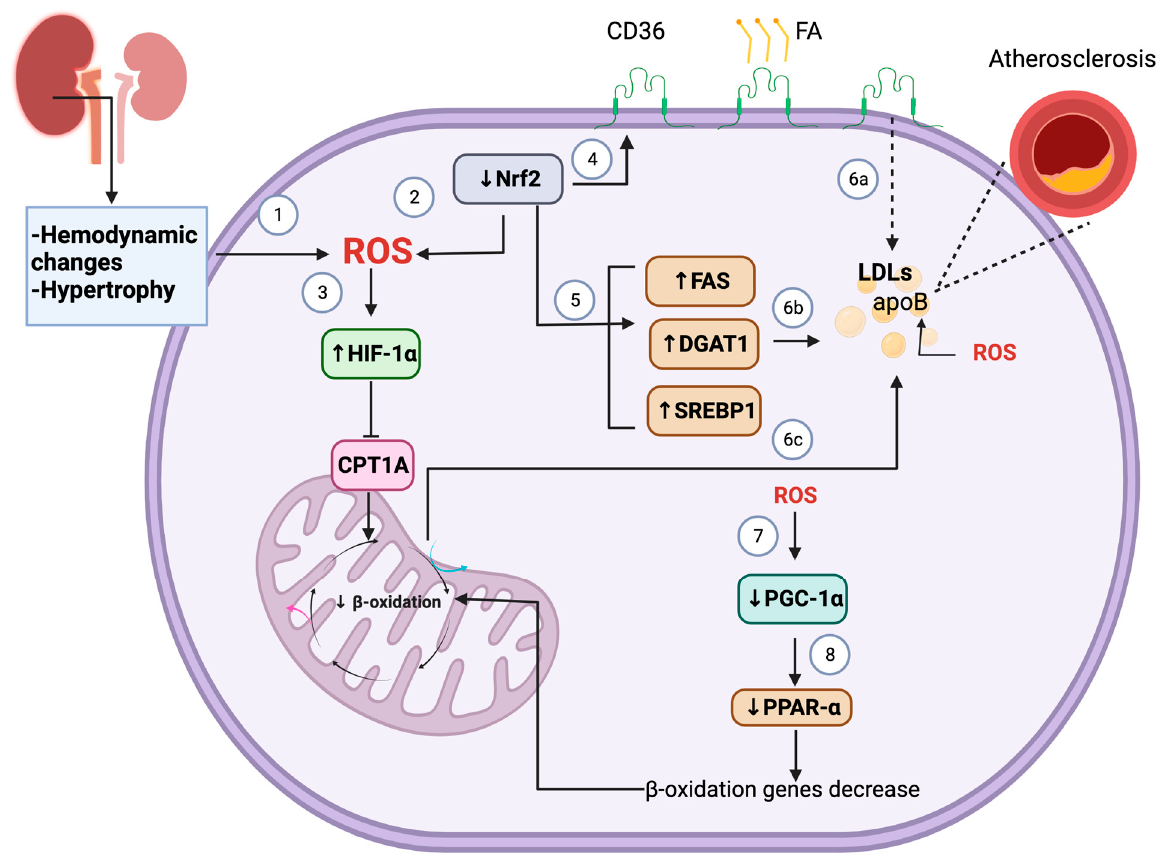
Figure 1. Oxidative stress causes dyslipidemia. (1) Hemodynamic changes and hypertrophy increase reactive oxygen species (ROS) levels. (2) Moreover, the downregulation of nuclear factor erythroid 2-related factor 2 (Nrf2) leads to ROS overproduction, which activates hypoxia-inducible factor (HIF)-1 α . (3) The activation of HIF-1 α causes the inhibition of carnitine palmitoyl transferase 1 A (CPT1A), the rate-limiting enzyme of β -oxidation in mitochondria, inducing the downregulation of β -oxidation. (4) The downregulation of Nrf2 also causes the increase of cluster of differentiation 36 (CD36), which augments fatty acid (FA) uptake. (5) Furthermore, the decrease of Nrf2 boosts the levels of enzymes involved in FA synthesis, such as FA synthase (FAS), diacylglycerol O-acyltransferase 1 (DGAT1), and sterol regulatory-element binding protein 1 (SREBP1). (6a) The increase in CD36 levels, (6b) the upregulation of FA synthesis enzymes, and (6c) the downregulation of β -oxidation lead to the accumulation of low-density lipoproteins (LDLs). LDLs can be oxidized via ROS into apolipoprotein B (apoB), contributing to atherosclerosis. (7) ROS also downregulates peroxisome proliferator-activated receptor γ co-activator 1 α (PGC-1 α ), which influences (8) the decrease of peroxisome proliferator-activated receptor-alpha (PPAR- α ), leading to β -oxidation genes decrease. Another protein affected by ROS is nuclear factor erythroid 2-related factor 2 (Nrf2), which is commonly downregulated in CKD [54]. In contrast, the levels of Kelch-like-ECH associated protein-1 (Keap-1), a negative regulator of Nrf2, are upregulated, possibly con- tributing to low levels of Nrf2 [55]. The decrease in Nrf2 has been related to FA metabolism alterations. In line with this, in type 2 diabetes, the low levels of CPT1A and